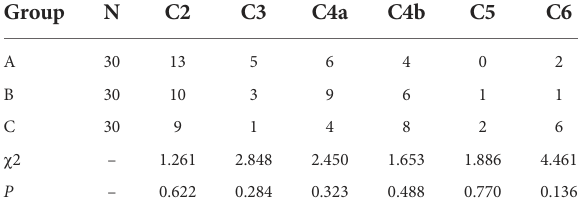
TABLE 2 Grade of varicose veins in three groups ( n ). Group